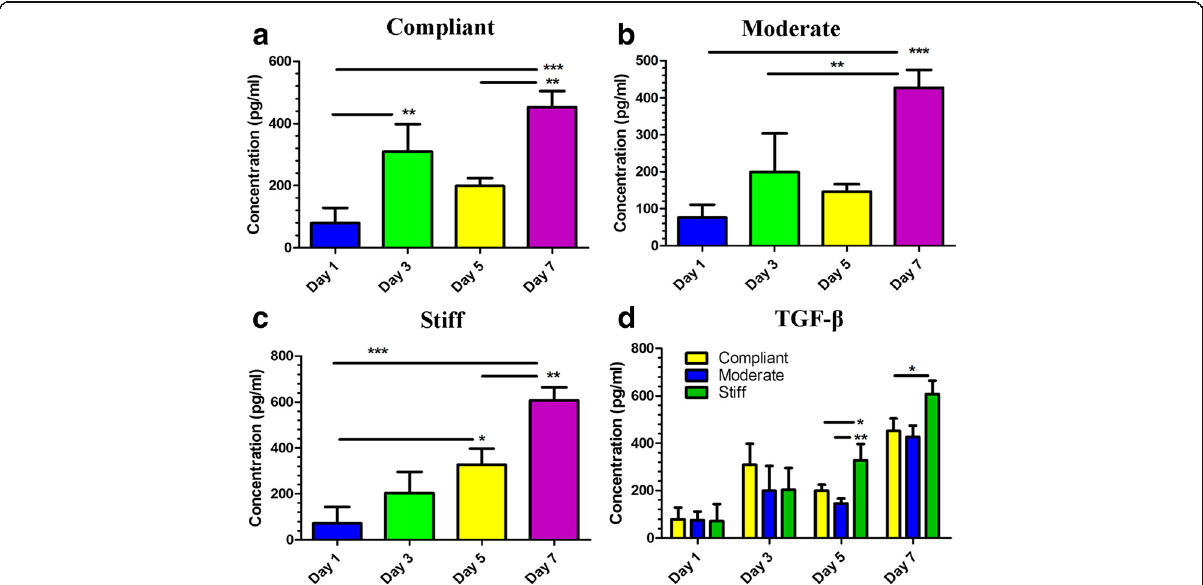
Fig. 7 TGF- β production from HMFs encapsulated in mTG hydrogels. HMFs were encapsulated in compliant, moderate and stiff hydrogels and conditioned media was collected at days 1, 3, 5 and 7 of culture for quantification of secreted TGF- β . Overall, TGF- β levels increased during the culture period for HMFs encapsulated in compliant ( a ), moderate ( b ) and stiff ( c ) hydrogels. ( d ) TGF- β production was significantly greater for HMFs encapsulated in stiff hydrogels at days 5 and 7 of culture. * p ≤ 0.05; ** p ≤ 0.01; *** p ≤